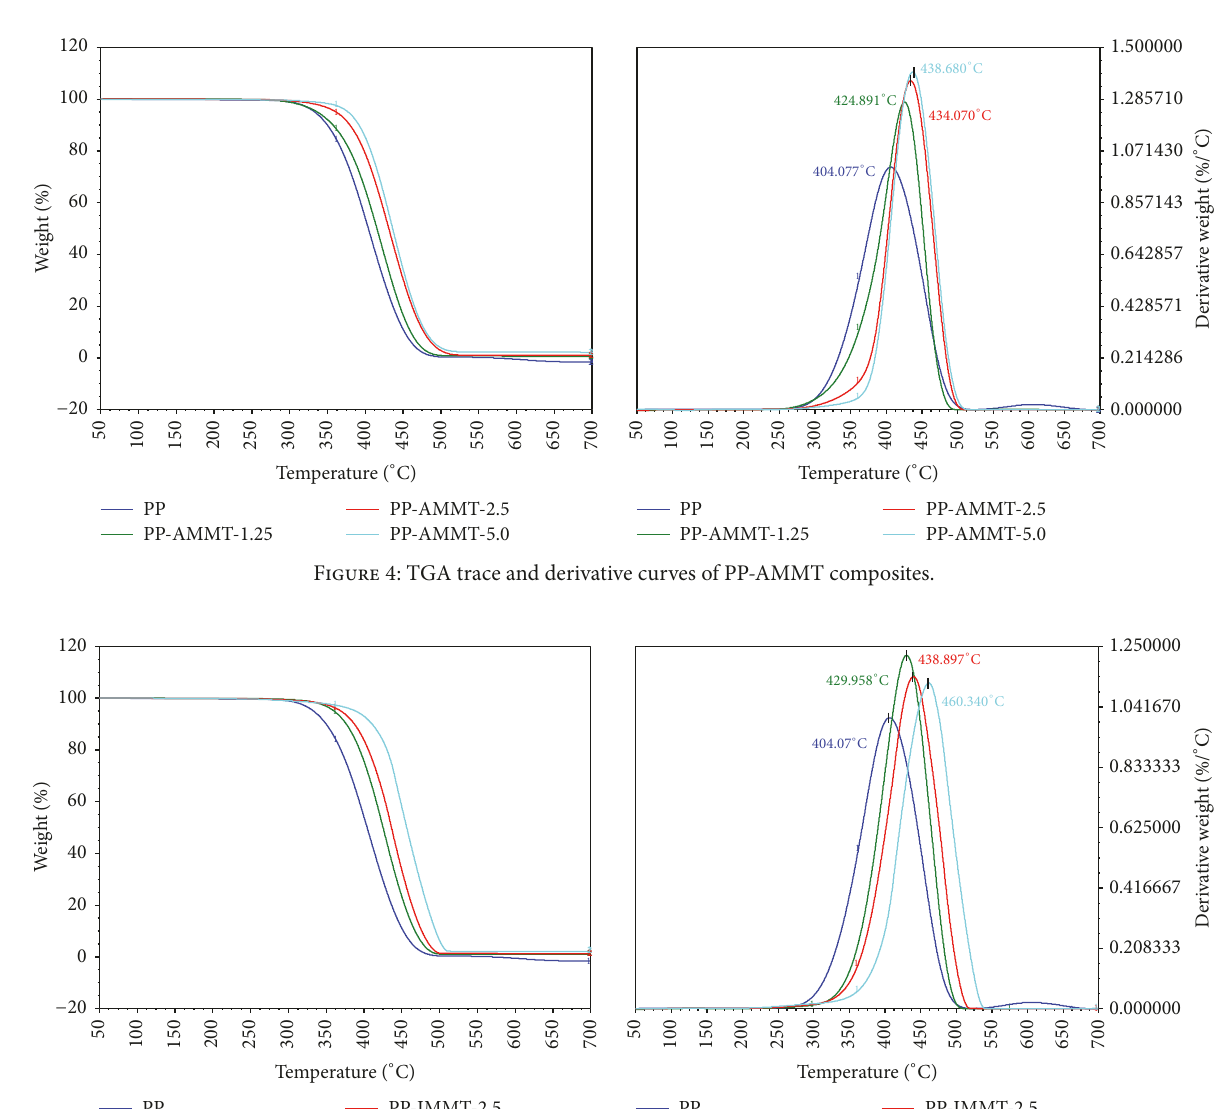
Figure 3: Differential scanning calorimetric curves of PP, PP-AMMT, and PP-IMMT composites.